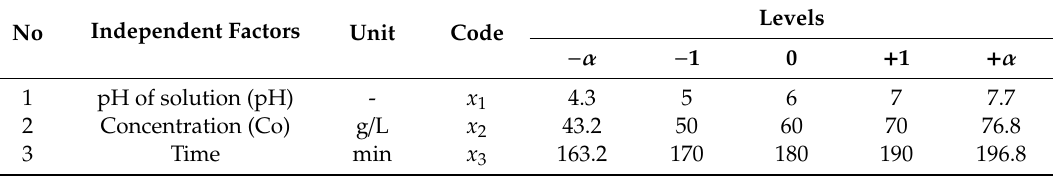
Table 1. List of variables for optimization of Congo red (CR)